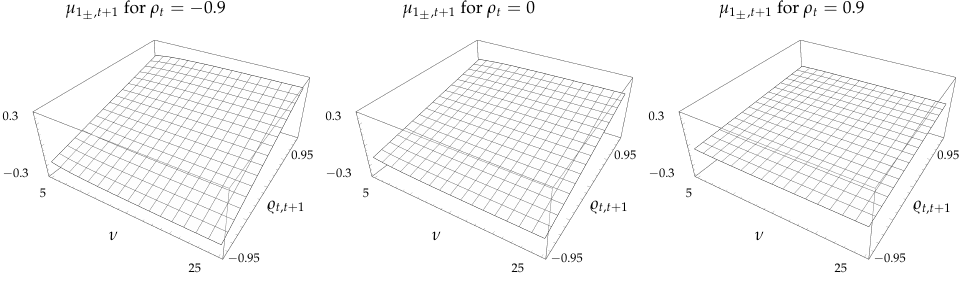
Figure 1. Expected CSM return, µ 1